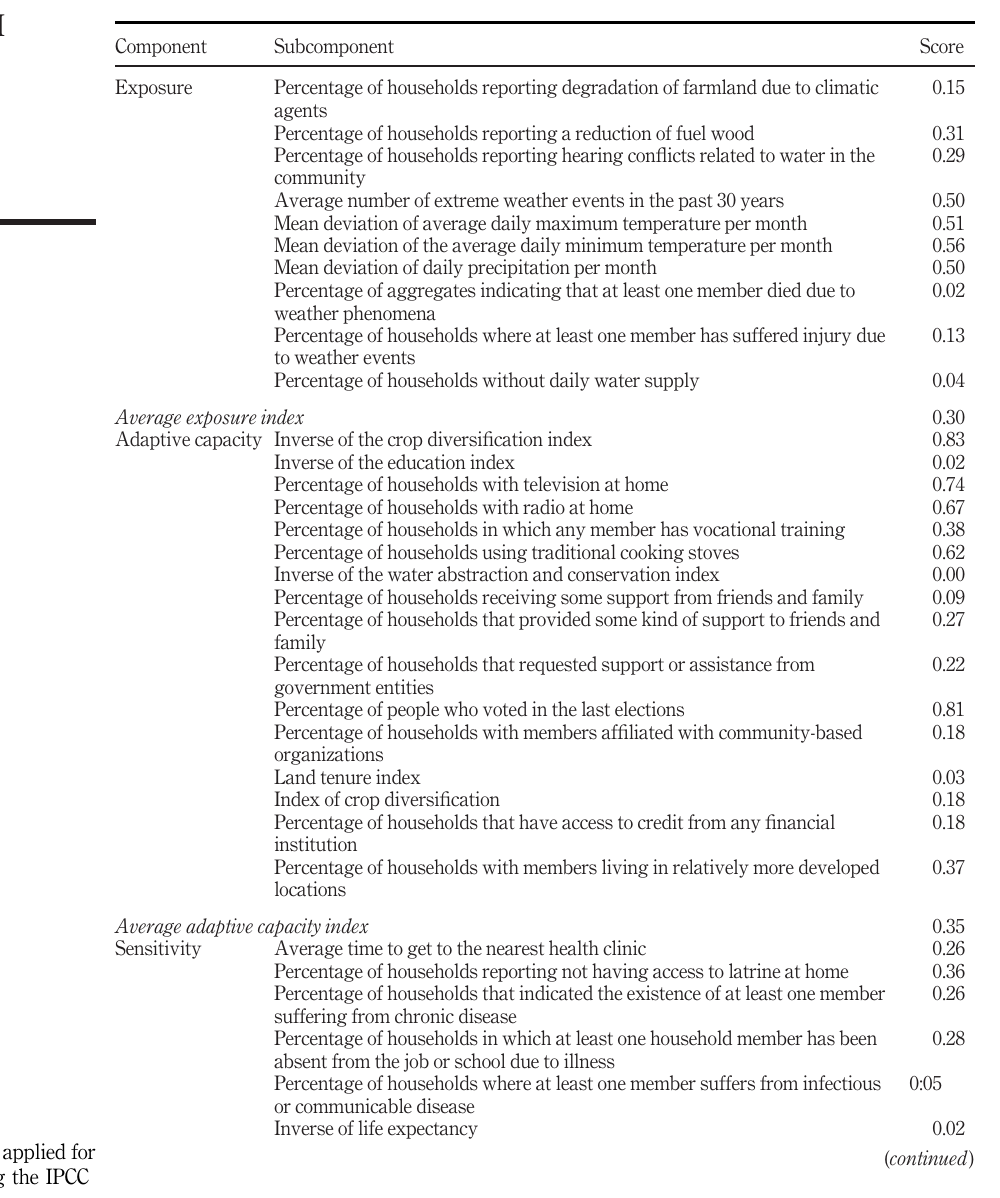
Table II. Indicators applied for calculating the